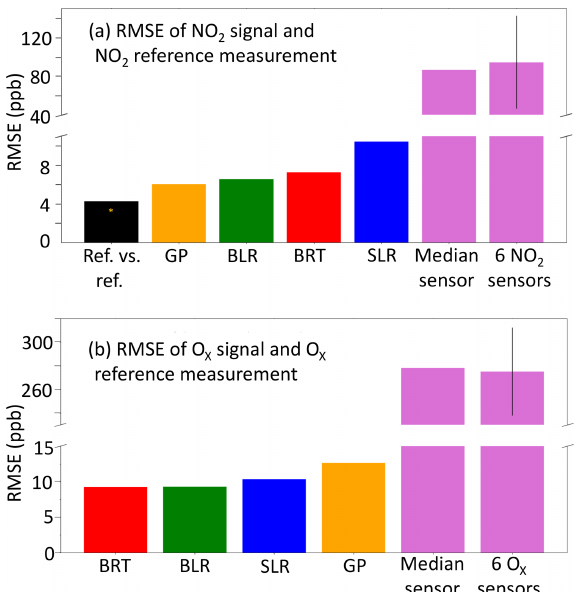
Figure 7. Comparison of the RMSE calculated for electrochemical sensor signal data treatment including individual sensors and a clus- ter of six using factory calibration, SLR and three ML techniques; when available, a reference vs. reference RMSE is also included. (a) NO 2 ; (b) O x